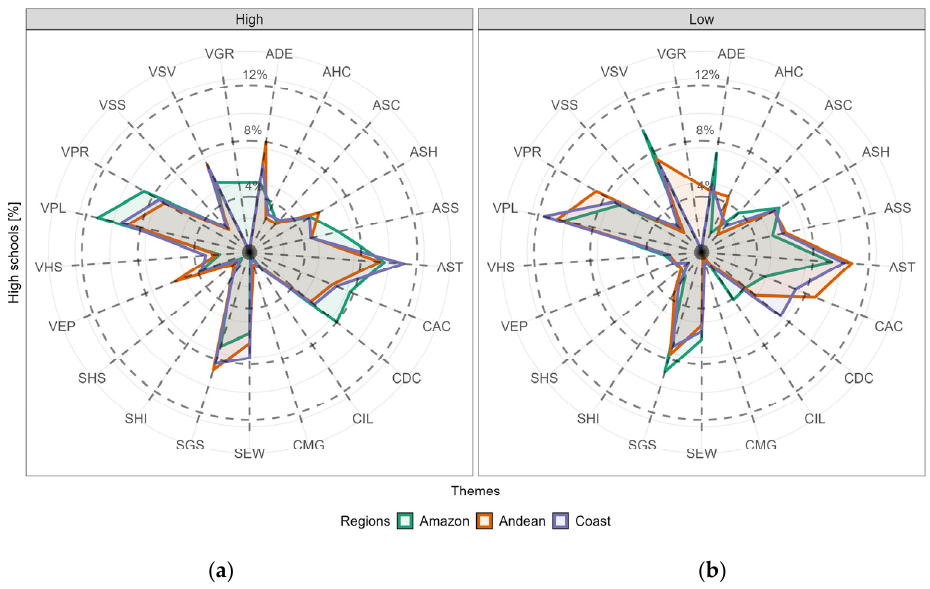
Figure 6. Frequent themes derived from the best predictive answer observed in the models for ( a )